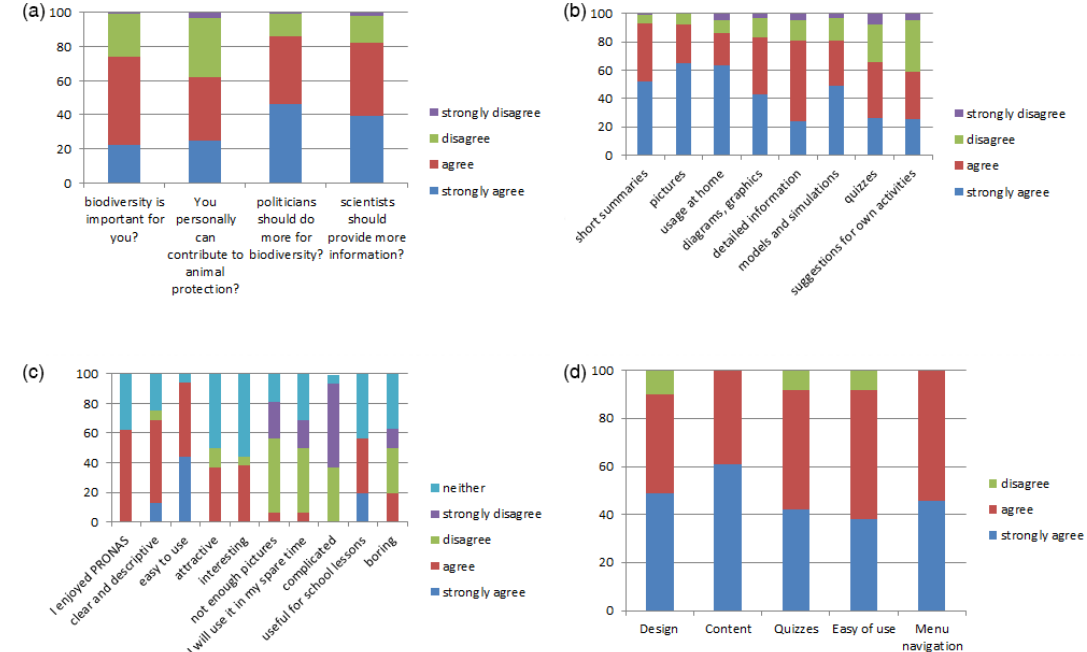
Figure 4. Results of evaluation studies with different target groups of German students and teachers: (a, b) preliminary study in the starting period with 88 students (12 to 18 years) of a school in Halle. They had to answer the questions (a) “do you think that... ?” and (b) “which general software elements are important for you?”; (c) 16 students (16 to 17 years) of a school in Leipzig evaluated the beta version of PRONAS; (d) 14 educators who were involved in the development evaluated the final version of